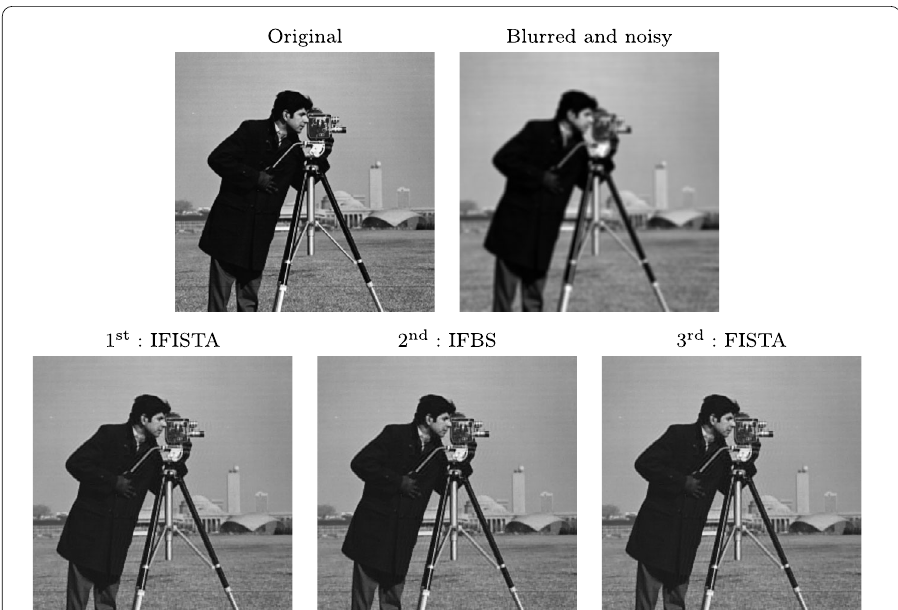
Figure 5 Top three fast processing with high performance for deblurring of Cameraman